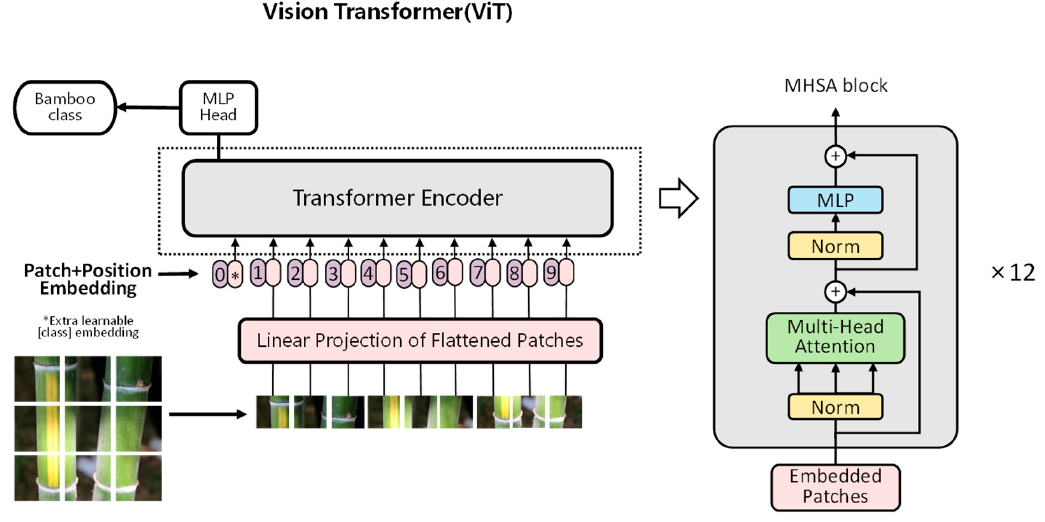
Figure 4. The framework of ViT [22].